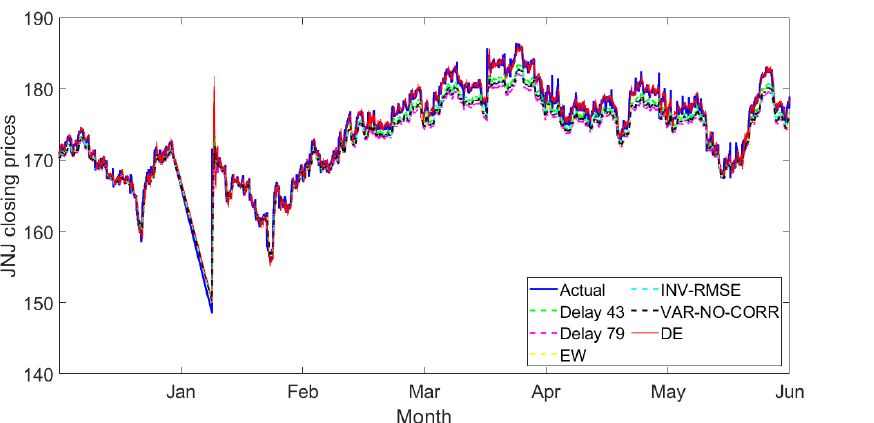
Figure 11. The forecasting curve for actual data versus the individual and combination methods of JNJ stock obtained from the MLP model between January and June 2022.